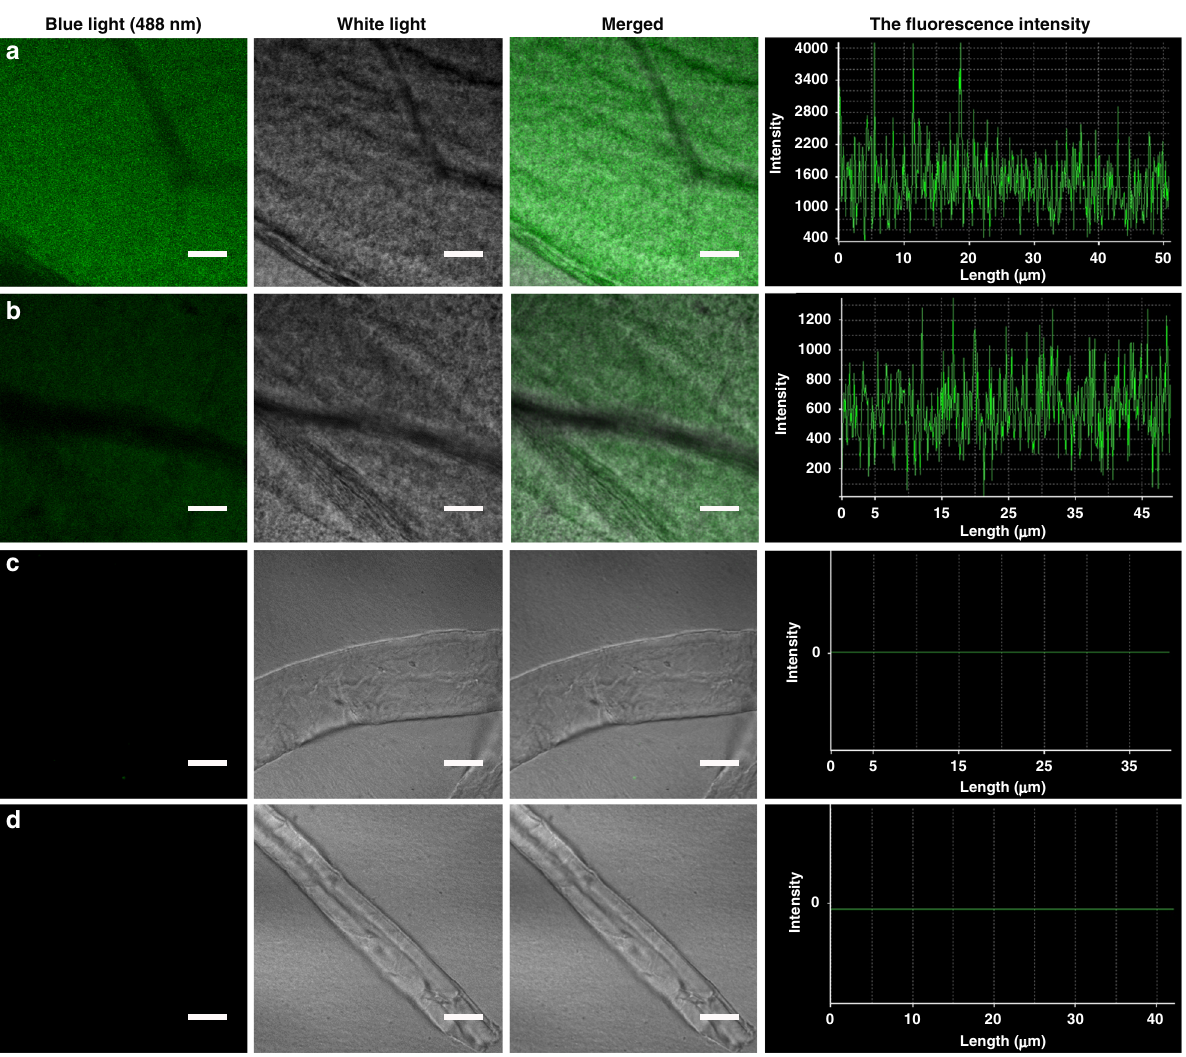
Fig. 3 Detection of fl uorescence intensity. The fl uorescence intensity of HC-6CF-BC, LC-6CF-BC, Im-6CF/BC and BC was detected using CLSM under the same parameter settings. a HC-6CF-BC; b LC-6CF-BC; c Im-6CF/BC; d BC. The average fl uorescence intensities of a HC-6CF-BC and b LC-6CF-BC were 1492 a.u. and 612 a.u., respectively. However, no fl uorescence was observed in c Im-6CF/BC and d BC, and both fl uorescence intensities were zero. The scale bar corresponds to 10 μ